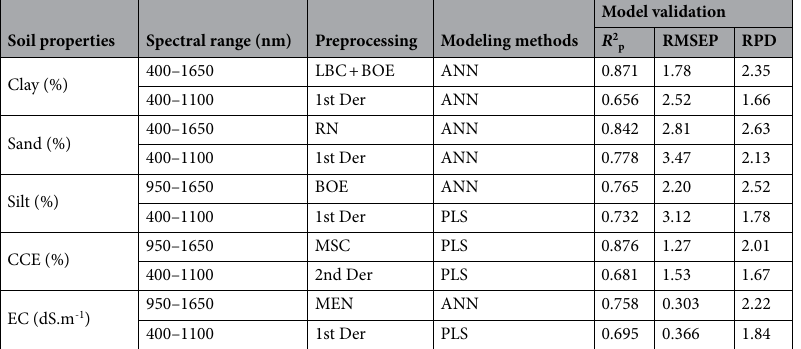
Table 5. The results of the best models, obtained from optimum and CCD spectral data for estimating physicochemical properties of soil. ANN artificial neural networks, BOE baseline offset elimination, CCE calcium carbonate equivalent, EC electrical conductivity, LBC linear baseline correction, MEN mean normalization, MSC multiplicative scatter correction, PLS partial least squares, R 2 p coefficient of determination in prediction, RMSEP root mean square error of prediction, RN range normalization, RPD Residual predictive deviation, 1st Der. first derivative, 2nd Der. second